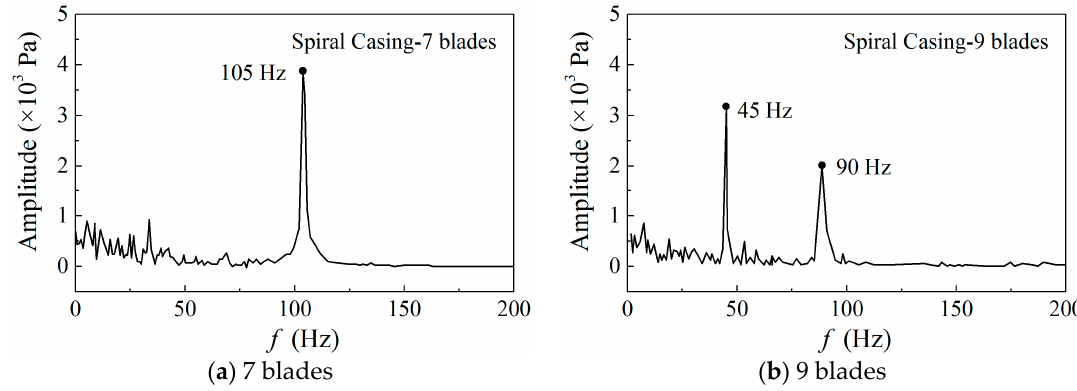
Figure 22. The main frequencies of pressure fluctuations at spiral casing (7 blades and 9 blades).